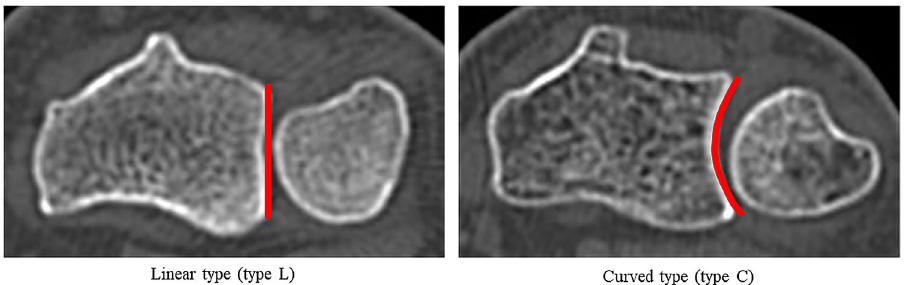
Figure 1. Typical computed tomographic images in the transverse plane of each type of sigmoid